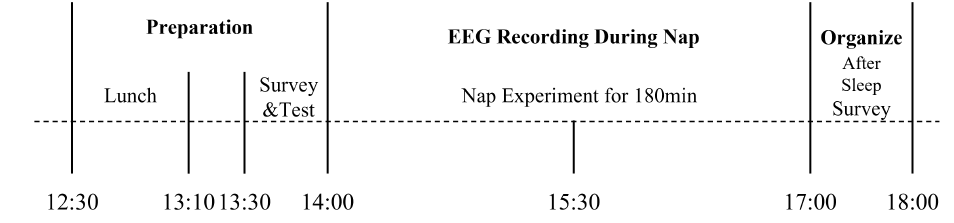
Figure 4. Experimental procedure to record EEG signals during the nap on the recliner chair for measuring nap time